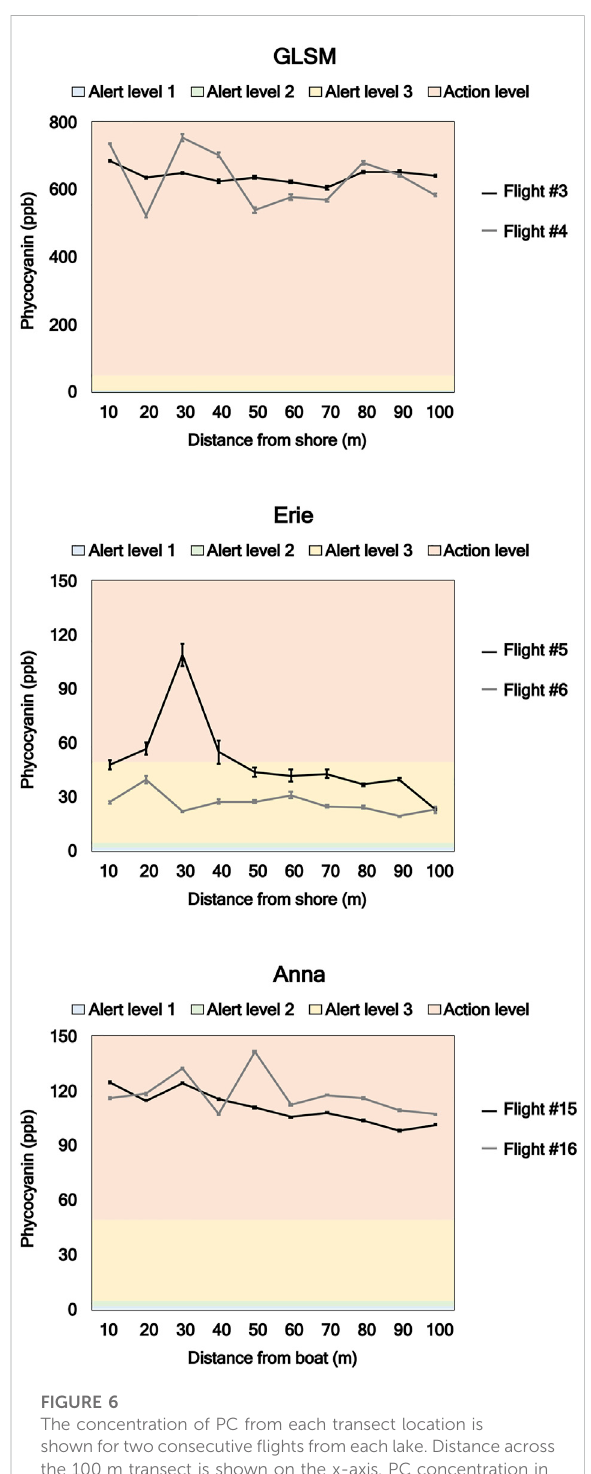
FIGURE 7 Graphical representation of total phosphorus from two consecutive fl ightscollectedonthesameday,foreachfreshwaterlake. The color bands denote lake water quality as oligotrophic (blue), mesotrophic (green), eutrophic (yellow), and hypereutrophic (orange) (Table 1). Trophic State Index (TSI) values for oligotrophic (TSI 0 – 40), mesotrophic (TSI 41 – 50), eutrophic (TSI 51 – 60), and hypereutrophic(TSI70 – 100)followtheTSItablepublishedby(Carlson, 1977). Collection points in 10-m increments are shown on the x-axis. Totalphosphorusmg/Lforboth fl ightsfromeachlakeisshownonthe y-axis. A total phosphorus concentration is 0 – 0.80 mg/L.